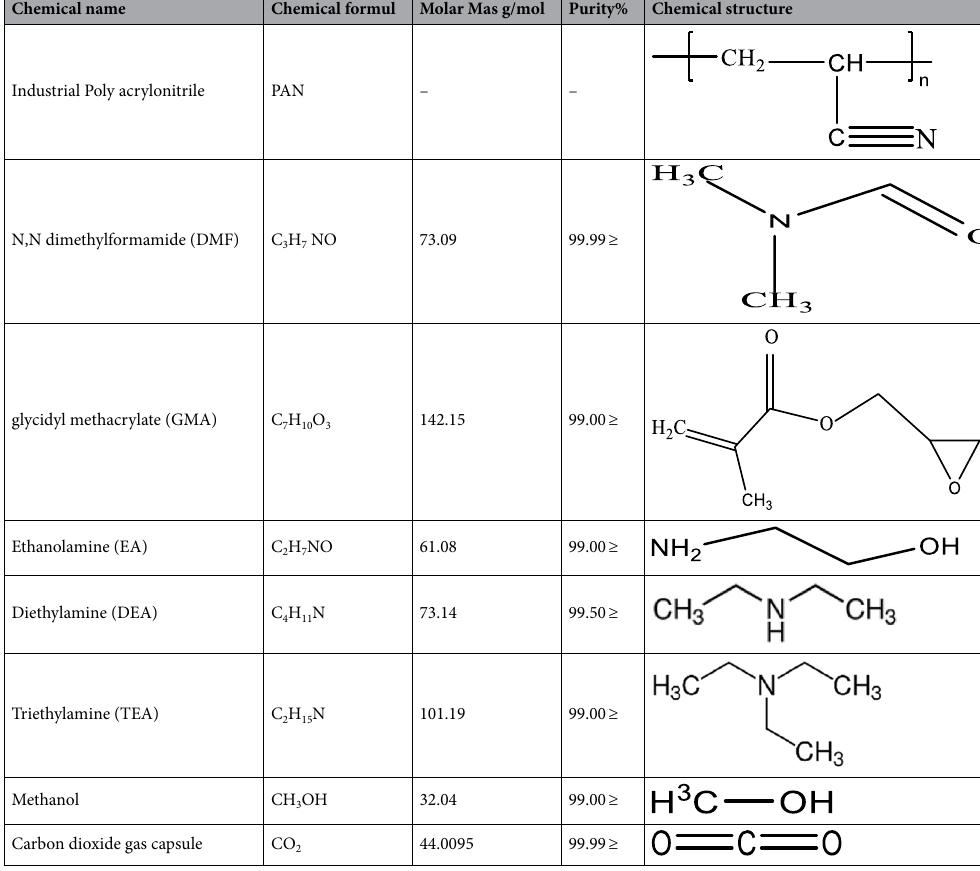
Table 1. Consumables in the synthesis of polymeric nanofibers under gamma irradiation.